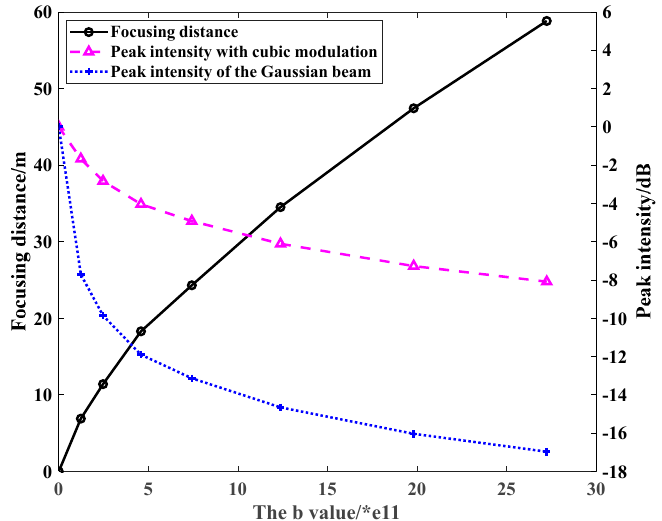
Figure 4. The trend of focusing distance and intensity with b value when loading the cubic modu- lation hologram.